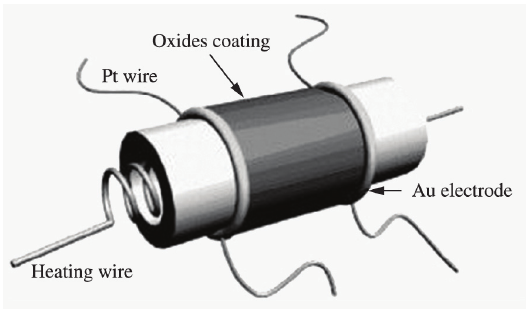
Figure 1. Schematic diagram of the gas sensor structure.